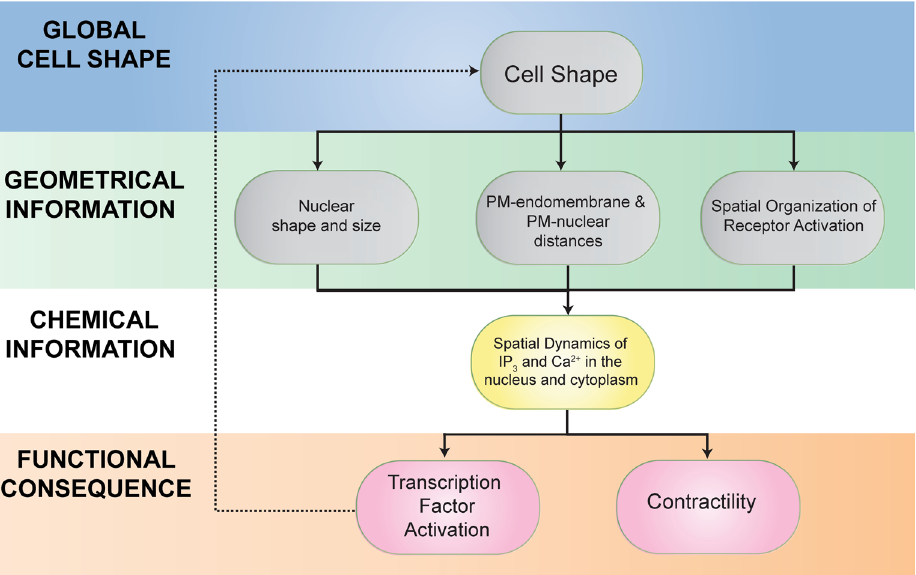
Figure 7. Systems approaches to controlling signaling through subcellular organization hierarchy. Physical determinants such as shape and geometrical information within the cell interact with organelle location and chemical information transfer to impact cellular function and gene expression, which in turn, feedback into cell shape. While each of these effects—shape, organelle location, and chemical information—may separately lead to small changes in signaling; collectively, these effects can lead to altered cellular function including transcription factor activation and